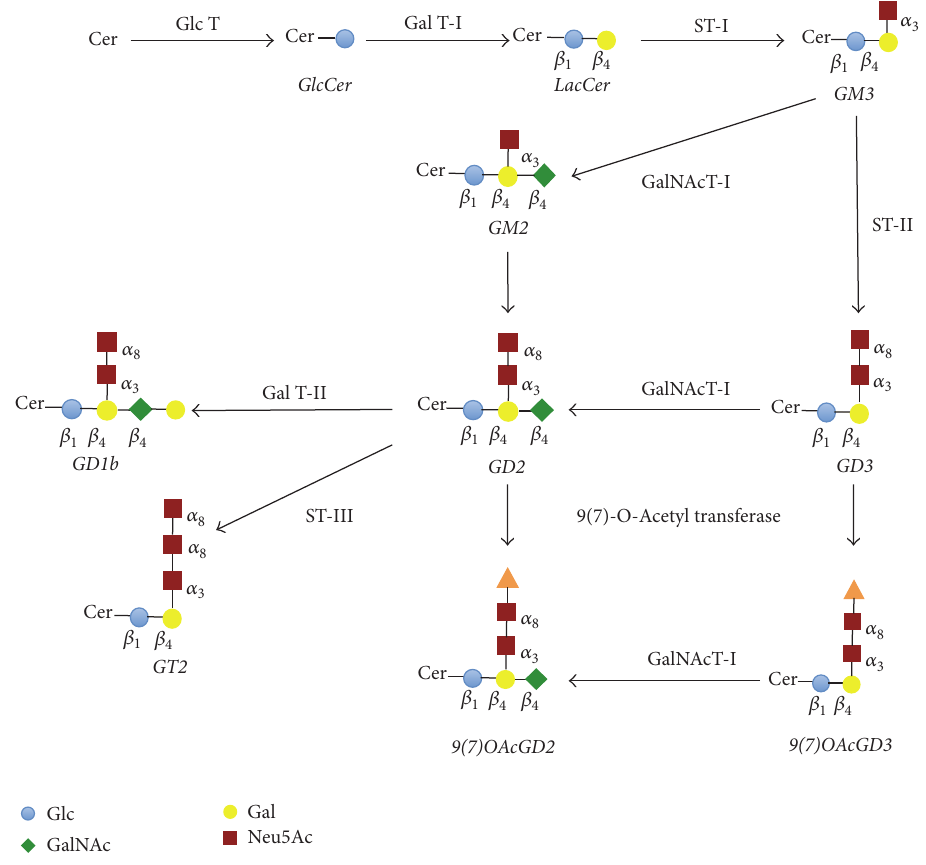
Figure 2: Schematic representation of the main pathway of O -acetyl-GD2 ganglioside biosynthesis. GD2 ganglioside is synthesized by the action of N -acetyl-galactosyltransferase I, which transfers N -acetyl-galactosaminyl residue from UDP- N -acetyl-galactosamine to GD3 [66]. GD2 can be also formed by the action of alpha 2–8 sialyltransferase II, which transfers a sialic acid residue from CMP-sialic acid to GM2 [66]. After synthesis, GD2 can be converted into either GD1b or GT2. GD1b is formed by the action of galactosyltransferase II that transfers a galactose residue from UDP-galactose to GD2. GT2 is synthesized by the action of sialyltransferase III that transfers a sialic acid residue from CMP-sialic acid to GD2. Then, the O -acetyl group addition occurs in a postsynthetic fashion [66]. Thus, O - acetyl-GD2 can be synthesized either by the action of sialate- O -acetyltransferase, which transfers the O -acetyl group to GD2, or by the action of N -acetyl-galactosyltransferase I, which transfers N -acetyl-galactosaminyl residue from UDP- N -acetyl-galactosamine to O -acetyl- GD3. Cer, ceramide; GlcCer, glucosylceramide; LacCer, lactosylceramide; Gal, galactose; Glc, glucose; GalNAc, N -acetylgalactosamine; Neu5Ac, N -acetylneuraminic acid; Glc T, glucosyltransferase; Gal T, galactosyltransferase; ST, sialyltransferase; GalNacT, N -acetyl- galactosaminyltransferase; CASD 1, Cas 1 domain containing 9(7)- O -acetyl